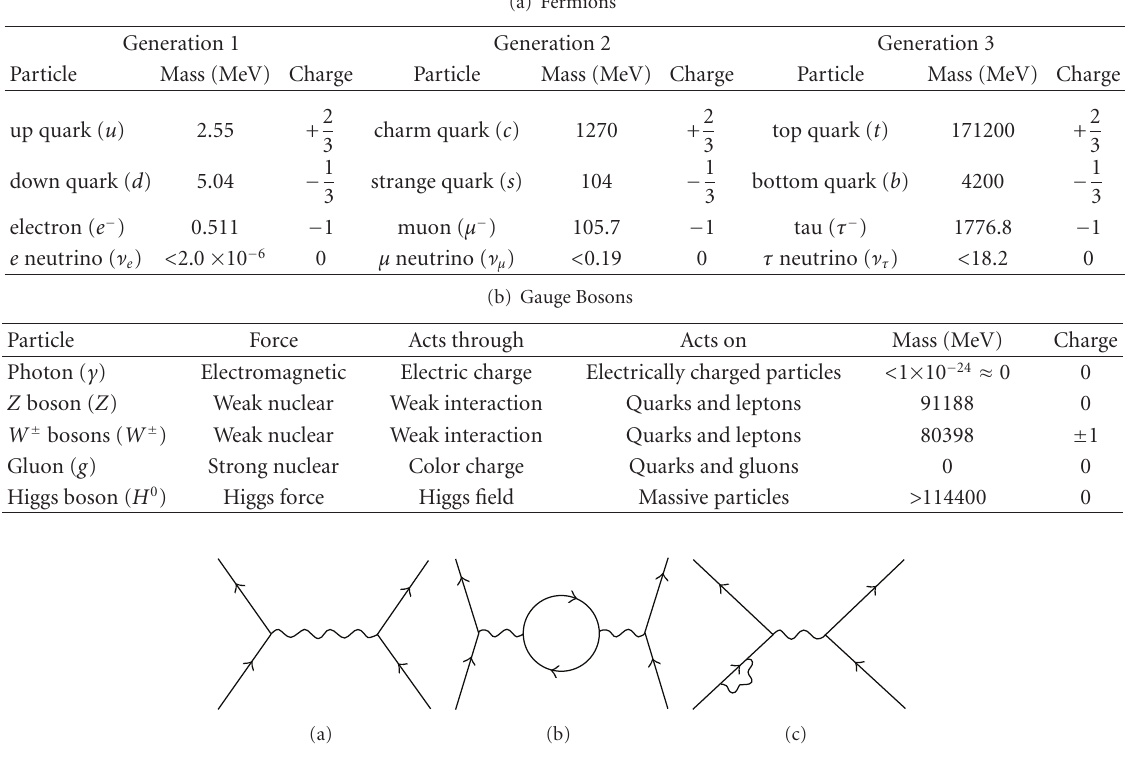
Figure 4: The tree level diagram on the left represents the electron-electron scattering process to the lowest order in perturbation theory. The two graphs on the right represent higher order processes (which can be thought of as loop corrections) and enter with higher powers of α